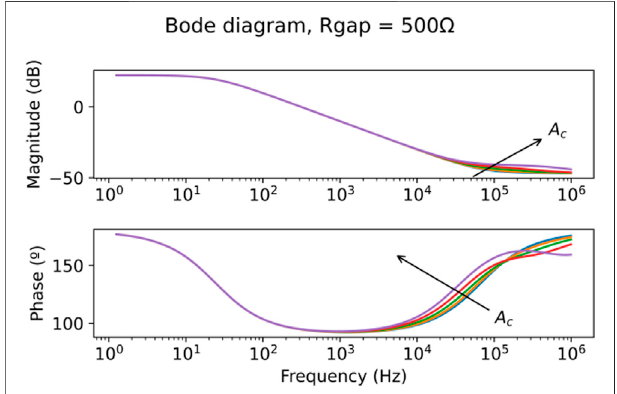
FIGURE 3 | Electrical impedance spectrometry for Hz(s) with R ct (cid:2) 1 . 3 M Ω , C dl (cid:2) 3 . 2 nF , R s (cid:2) 455 Ω , R gap (cid:2) 500 Ω and variations for A c ∈ ( 0 , A )